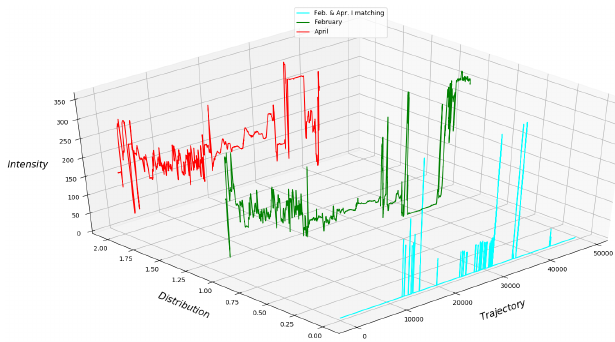
and Γ for Figure 9. Virtual light distribution based on light segments I 1 T I 3 T matching with the baseline Γ